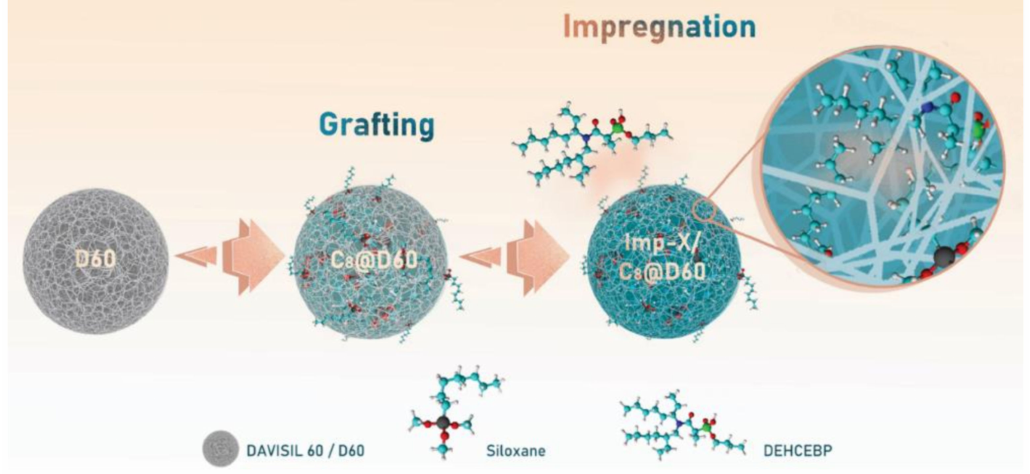
Figure 8. Schematic representation of the two-step process used to synthesize the amidophosphonate- impregnated